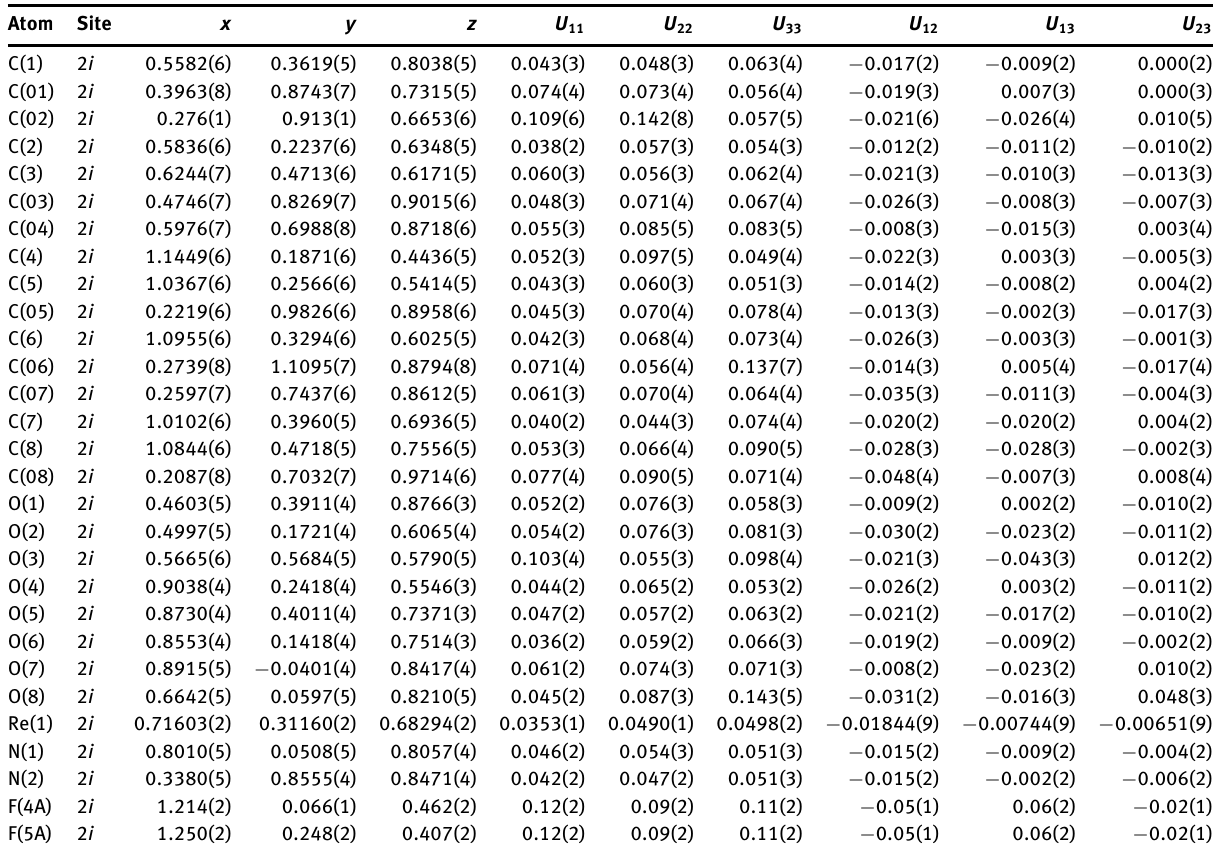
Table 3: Atomic displacement parameters (Å 2